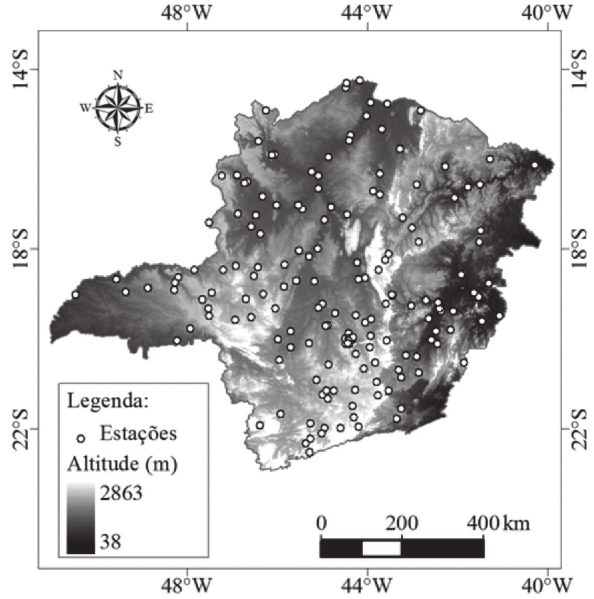
Figura 1. Modelo digital de elevação do Estado de Minas Gerais e distribuição espacial das estações meteorológicas utilizadas neste estudo (Freitas et al.,